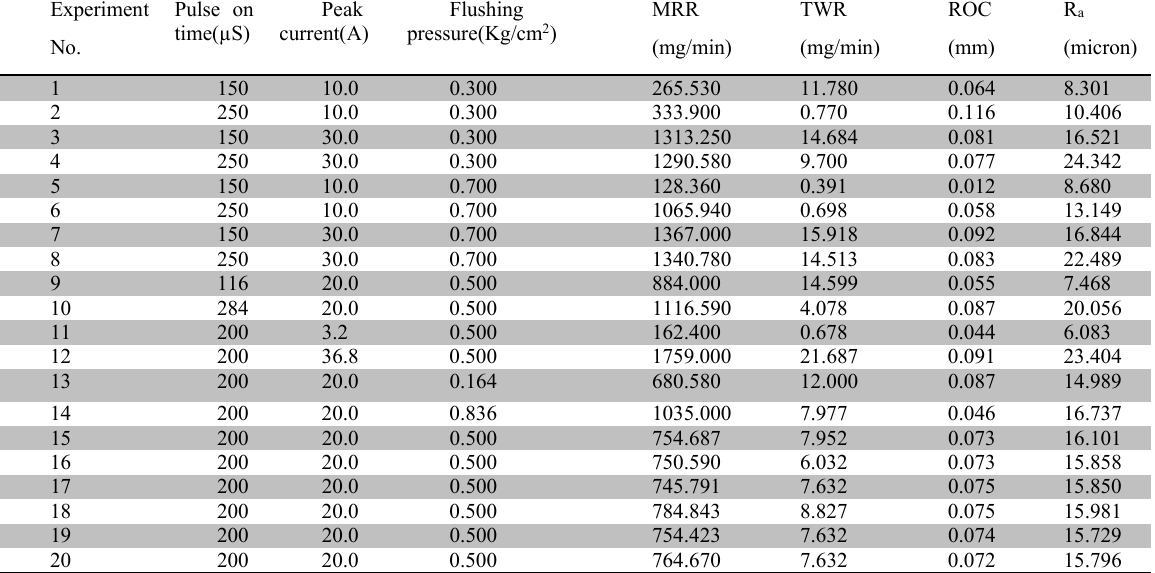
Design of experimental and